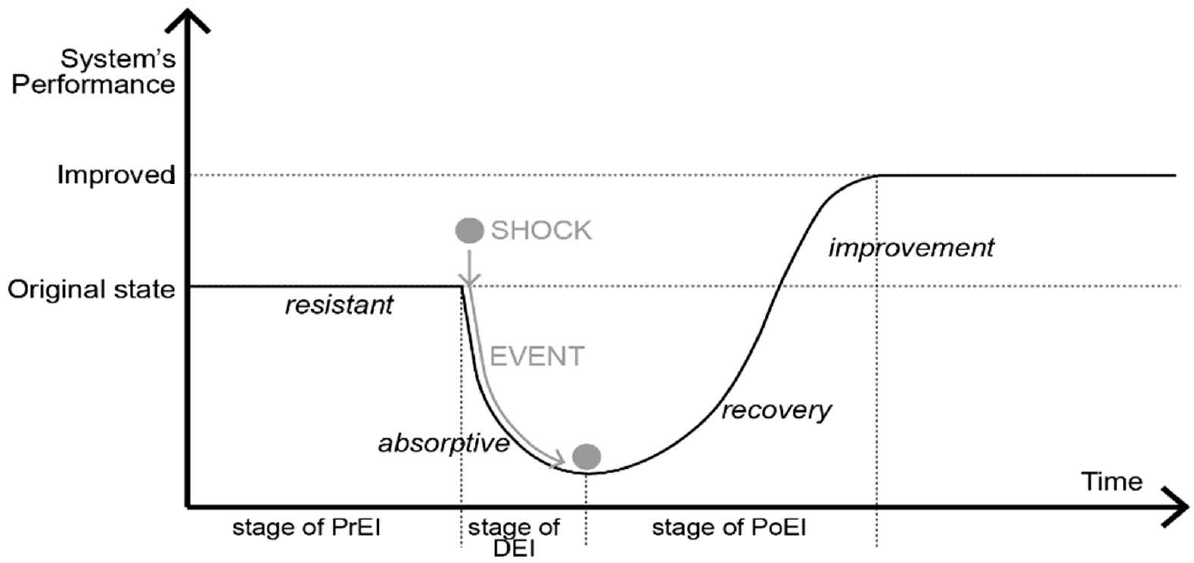
Figure 1. Urban transport performance in cycle to disruption.